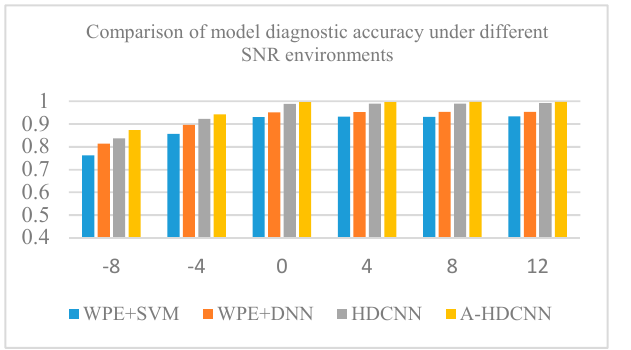
Table 9. Comparison of model diagnostic accuracy under different signal-to-noise ratio (SNR) environments.